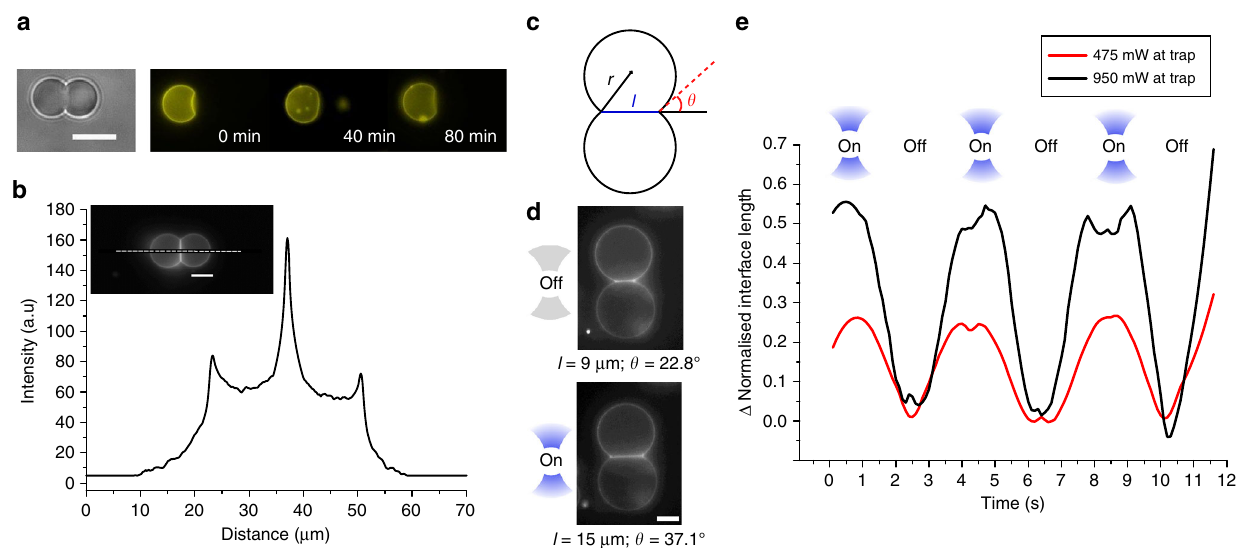
Fig. 4 Structural arrangement of VIMs and dependence on temperature. a Lack of diffusion of membrane-embedded Rh-PE between vesicle compartments suggests that the vesicle interfaces are composed of two adherent membranes as opposed to a hemifused diaphragm. b This is reinforced by a fl uorescence intensity pro fi le across a two-vesicle network (inset; dotted line) showing the fl uorescence of the interface membrane being double that of the external vesicle membrane. c Cartoon showing the characteristic parameters of a symmetric vesicle pair including vesicle radius ( r ), contact angle ( θ ) and interface length ( l ). d Turning on the optical tweezers to trap a vesicle (950 mW at trap; bottom vesicle trapped) triggered a change in both interface length and contact angle. e Network morphology could be dynamically alternated by sequential application and removal of the trap. This is demonstrated by the graph showing the change in interface length over time as the trap is tuned on and off, where the interface length is normalised with respect to vesicle radius. Lower applied powers resulted in smaller changes to interface lengths. Scale bars = 10 µ m for all images